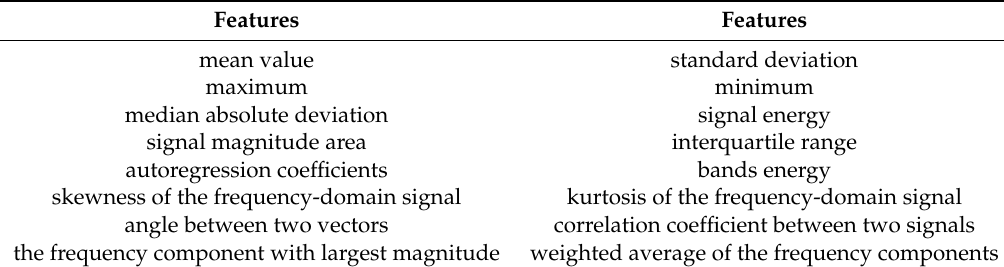
Table 2. A list of features for activity recognition.